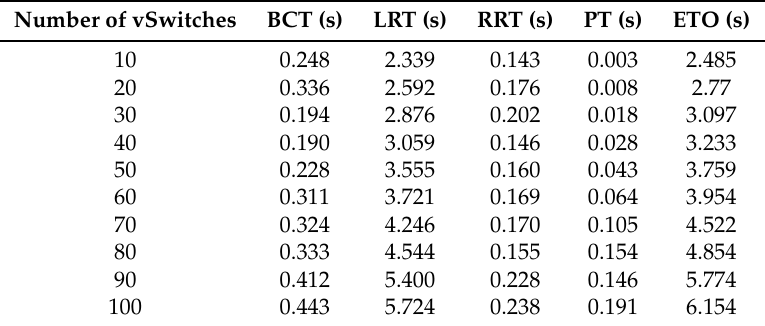
Table 10. Execution time overhead of